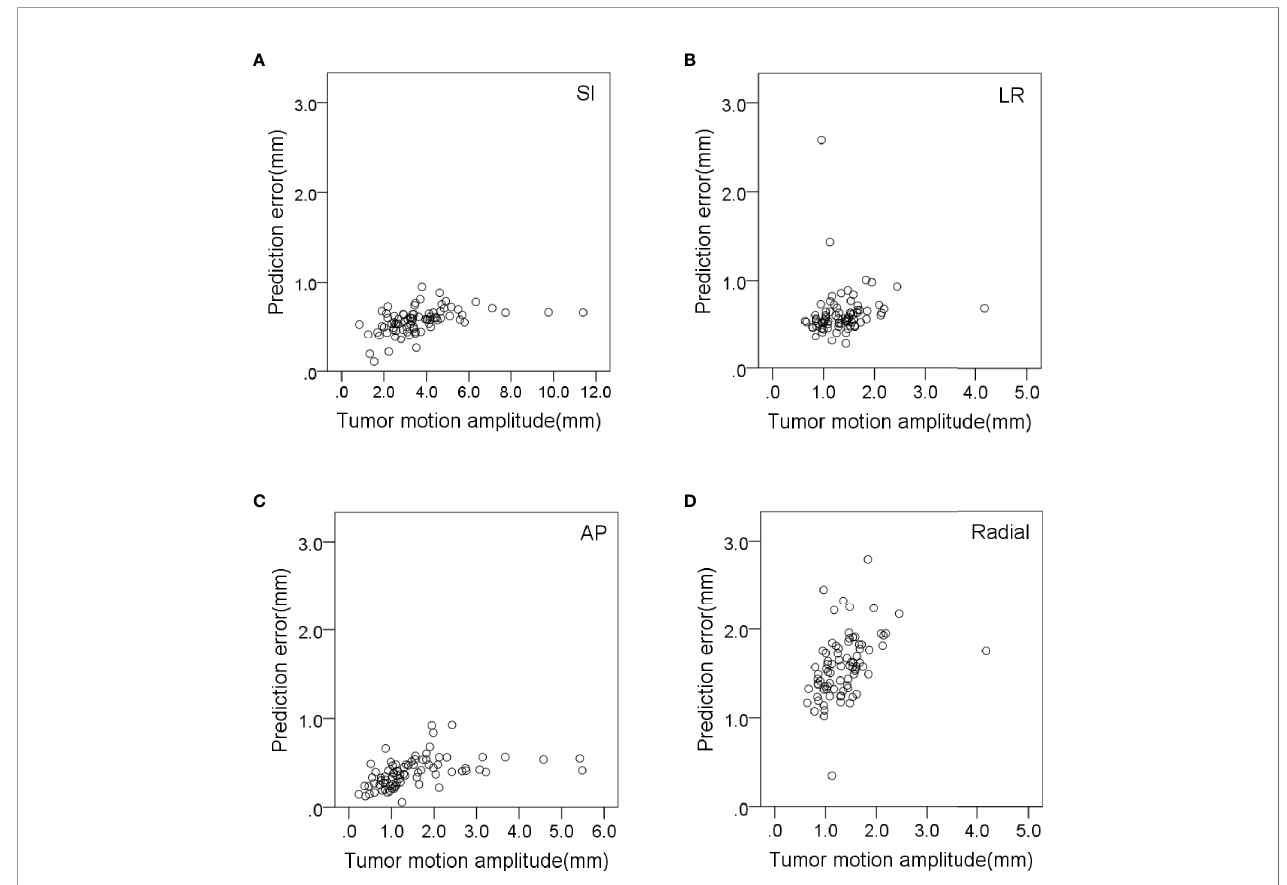
FIGURE 4 | Variation of prediction errors with tumor motion amplitude in (A) SI, (B) LR, (C) AP and (D) radial